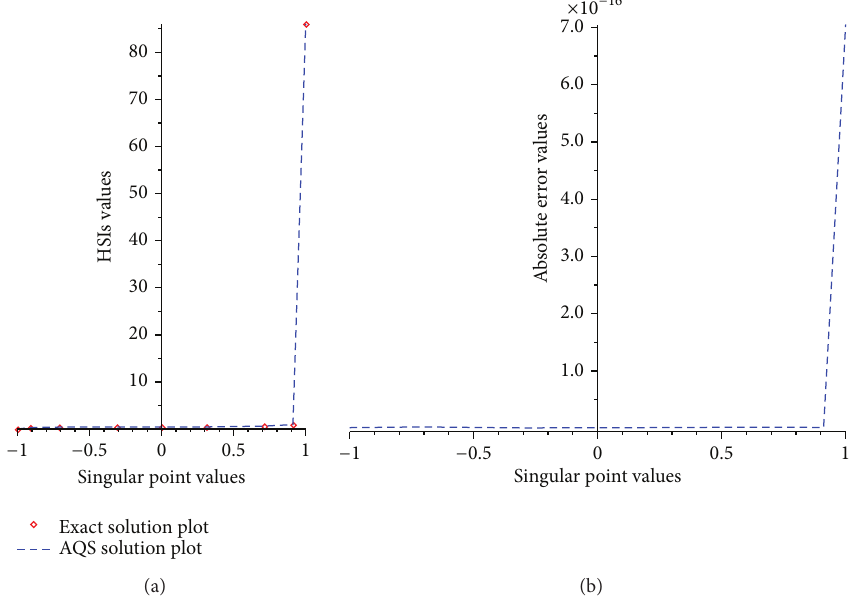
Figure 8: (a) Exact and AQS solutions when 𝑁 = 40 and ℎ(𝑡) = 1/(2 + 𝑡) and (b) absolute error between exact and AQS solution when 𝑁 = 40 and ℎ(𝑡) = 1/(2 + 𝑡)